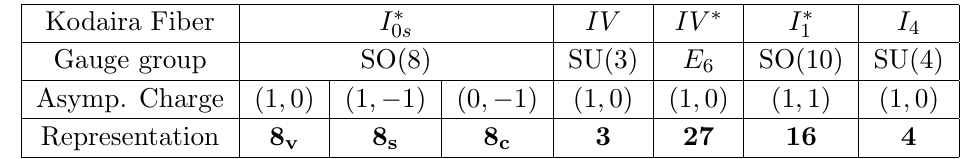
Figure 7 . The representation R of SO(10) with highest weight [0 ; 1 ; 0 ; 0 ; 0].